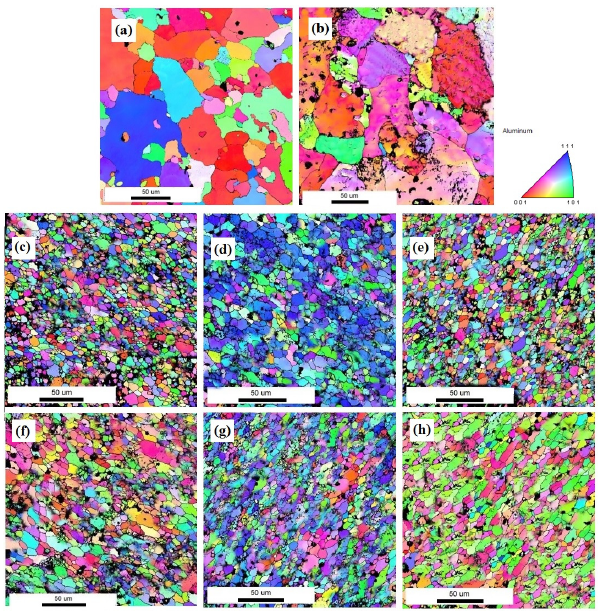
Figure 10. IPF maps portraying grain distribution in ( a ) BM-AA6061, ( b ) BM-AA7075, ( c – e ) NZ in upper, middle, and lower layer, ( f ) TMAZ of upper layer in AS, ( g ) TMAZ of middle layer in RS, and ( h ) TMAZ of lower layer in AS.